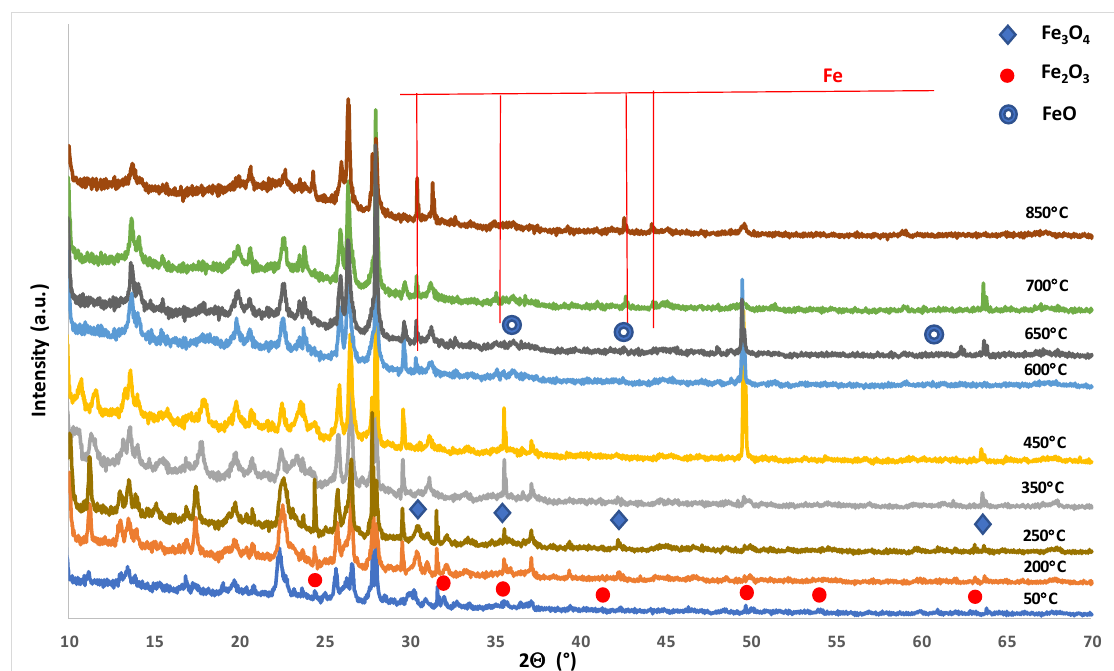
Figure 6. XRD, “in situ” reduction measurements performed in a mixture of 5%H 2 –95%Ar for pristine NZ material.